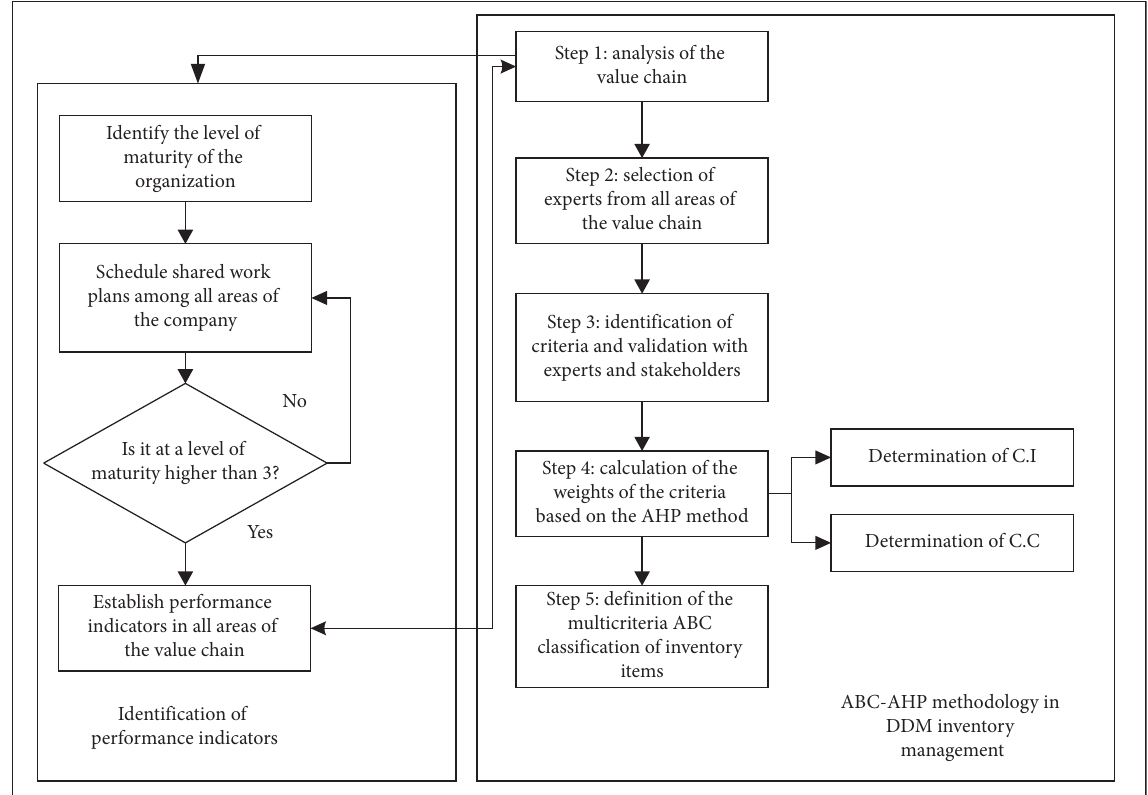
Figure 2: Proposed